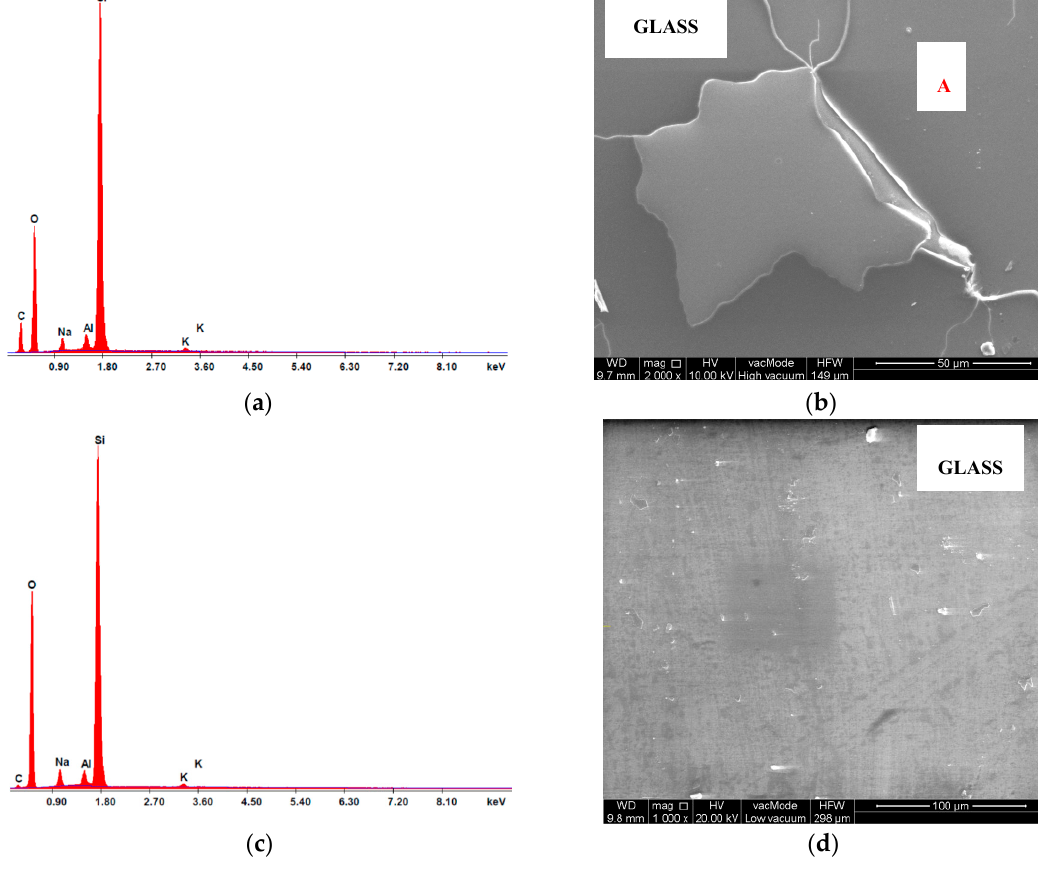
Figure 14. Analysis of glass cullet, 20 °C: ( a ) chemical composition spectrum of SEM-EDS, point A; ( b ) microstructure of glass, point A; ( c ) SEM-EDS chemical composition spectrum, area; ( d ) glass microstructure, area.